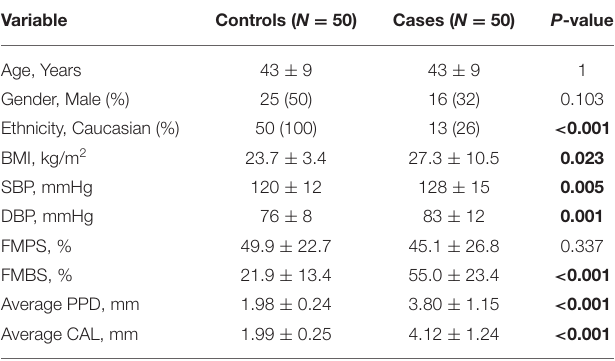
TABLE 1 | Participants’ characteristics at baseline (case-control study, N = 100).